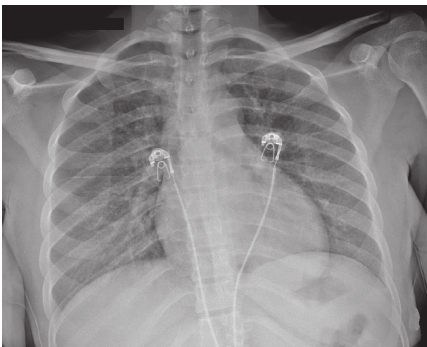
Figure 1: Chest radiograph showed bilateral homogeneous ground-glass